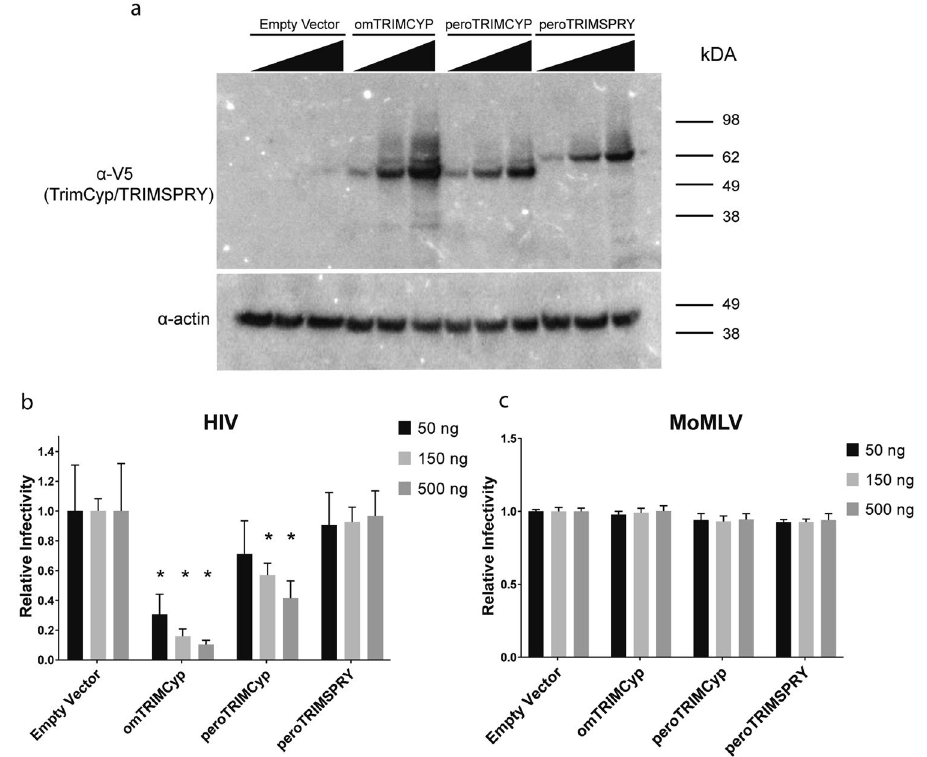
Figure 7. Evaluation of the antiretroviral activity of P. maniculatus TRIMCyp and TRIMSPRY. ( a ) Immunoblotting analysis of HEK293T cells transfected with 50, 150 or 500 ng of plasmids expressing the indicated genes was done using the indicated antibodies. For the uncropped version of the immunoblots see Supplementary Fig. S7C,D. Blot is representative of 3 independent experiments. ( b ) and ( c ) HEK293T cells were infected with ( b ) HIV-RenLuc or ( c ) MLV-LacZ 2 days following a transfection with indicated amounts of the plasmids expressing omTRIMCyp, peroTRIMCyp, peroTRIMSPRY or vector only. Normalized ( a ) Renilla luciferase or ( b ) Beta-galactosidase values are shown relative to the empty vector control. Error bars indicate standard deviation. Values represent average of 3 independent experiments. Statistical significance